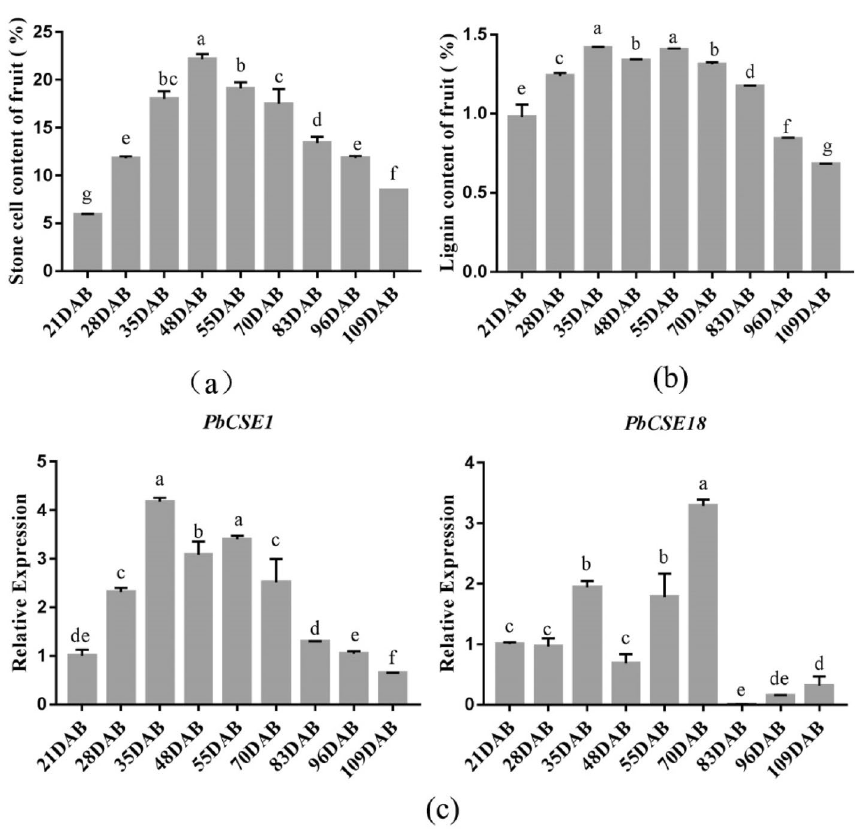
Figure 3. Expression analysis of the CSE -like genes during the formation of pear fruit lignin. ( a ) Stone cell content in ‘Dangshan Su’ pear during the growth phase. ( b ) Lignin content in ‘Dangshan Su’ pear during the growth phase. ( c ) A comparison of the relative expression levels of PbCSE1 and PbCSE18 during lignin synthesis. Different lowercase letters on a column indicated the treatment differs significantly at the 1%